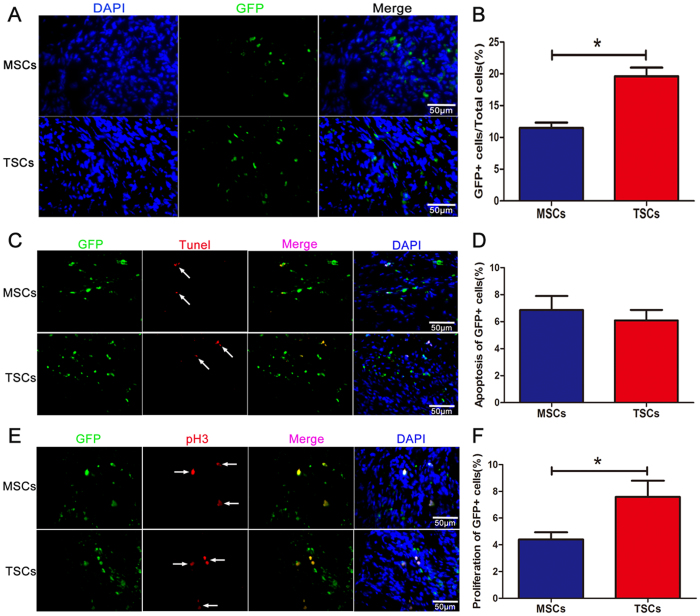
Retention of MSCs and TSCs after transplantation.(A) The retention of injected cells was detected by the percentage of GFP+ in all the cells in every field under fluorescent microscopy, and nuclei were counterstained with DAPI. (B) Quantification of GFP+ cells to total cells showed that the retention of TSCs was higher than the MSCs (*P < 0.05) (Table S1). (C) The co-expression of GFP and Tunel indicated the apoptosis of implanted cells in vivo. (D) Quantification of co-expression of Tunel and GFP cells showed no difference between TSCs and MSCs in apoptosis after transplantation (Table S3). (E) The co-expression of GFP and pH3 indicated the proliferation of implanted cells in vivo. (F) Quantification of co-expression of pH3 and GFP cells showed that TSCs exhibited more proliferation than MSCs in vivo (*P < 0.05) (Table S2). n = 6 for each group. Data are depicted as mean ± SD.